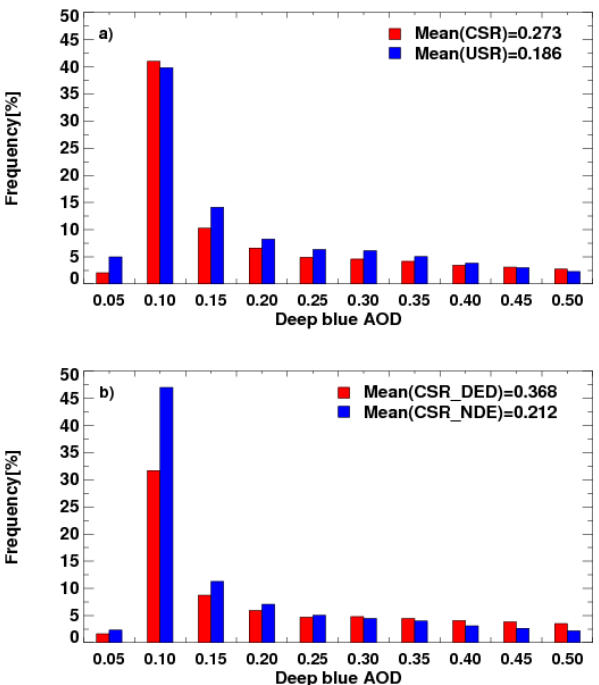
Fig. 5. Comparison of the MODIS deep blue aerosol optical depths (AOD) (a) over the CSR and USR and (b) over the CSR for dust event days (DED) and non dust event days (NDE) during spring (March to May). The histogram intervals are 0.05.